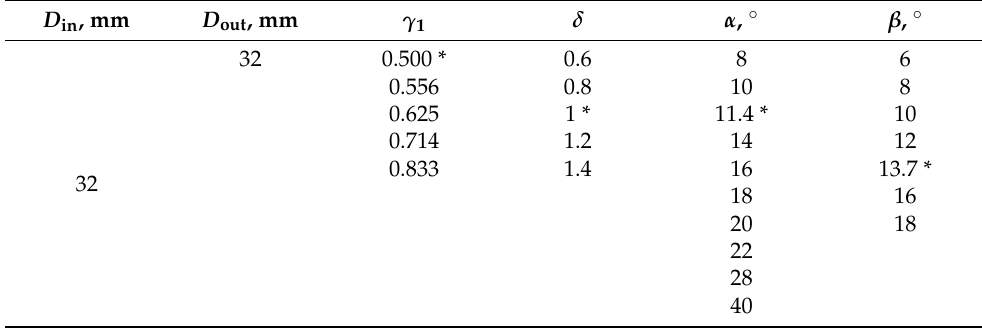
Table 5. Structural parameters in the optimization of VT.